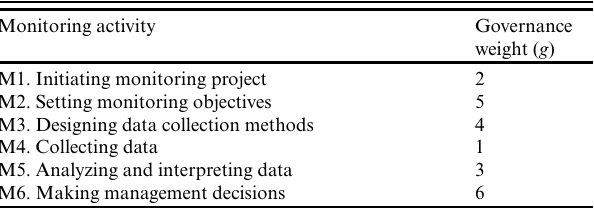
Table 2 . Monitoring activities and associated governance weights